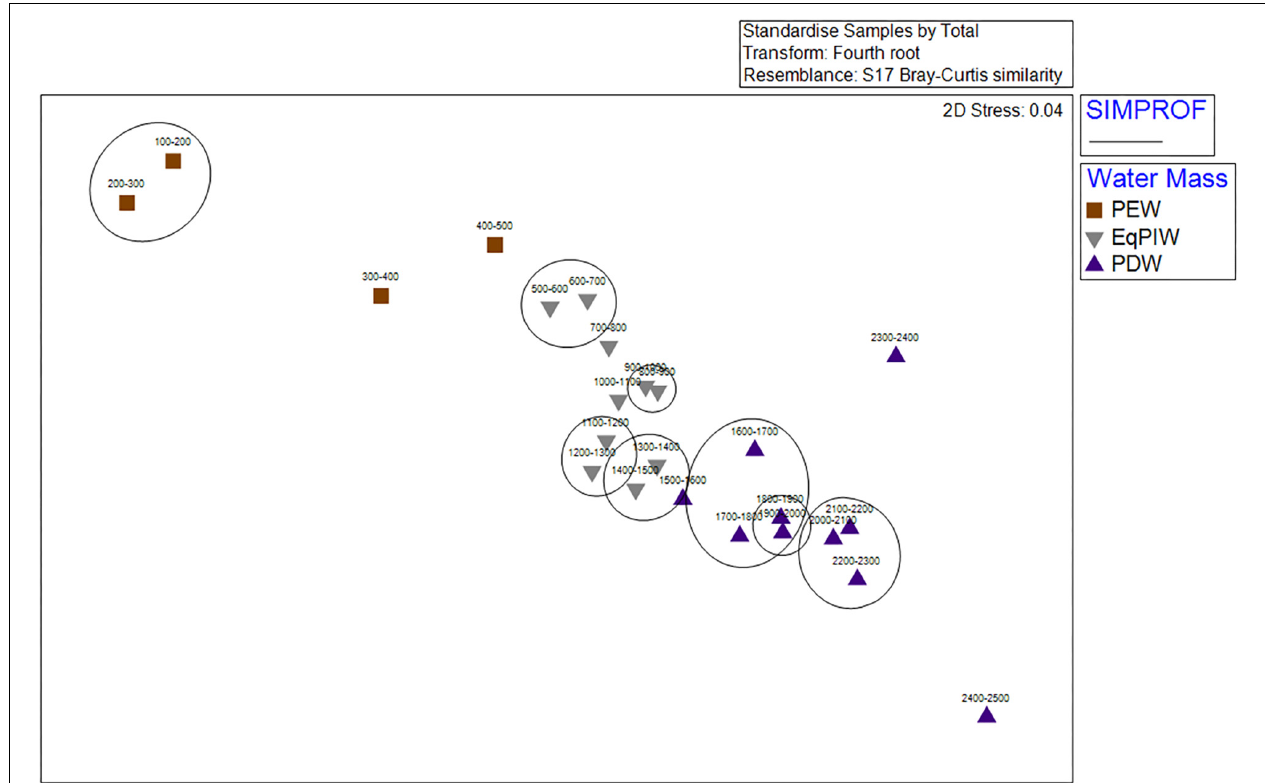
FIGURE 7 | Non-metric multidimensional scaling ordination (nMDS) of 100 m depth-averaged samples. Abundances within samples were 4th root transformed, standardized, and analyses were conducted using a Bray-Curtis Similarity matrix. Symbols indicate the water masses in which those samples occurred. Significant SIMPROF groupings from cluster analysis are overlaid in